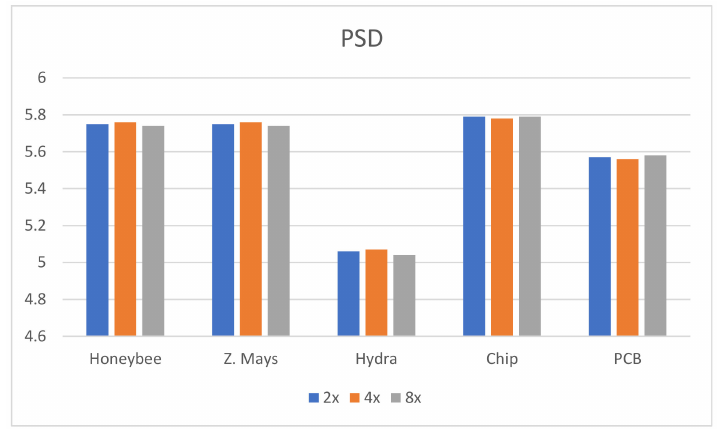
Figure 12. PSD comparison between the × 2, × 4, and × 8 upscaling factors. The PSD value varies across different specimen. However, in most of the cases, the × 2 upscaling performs